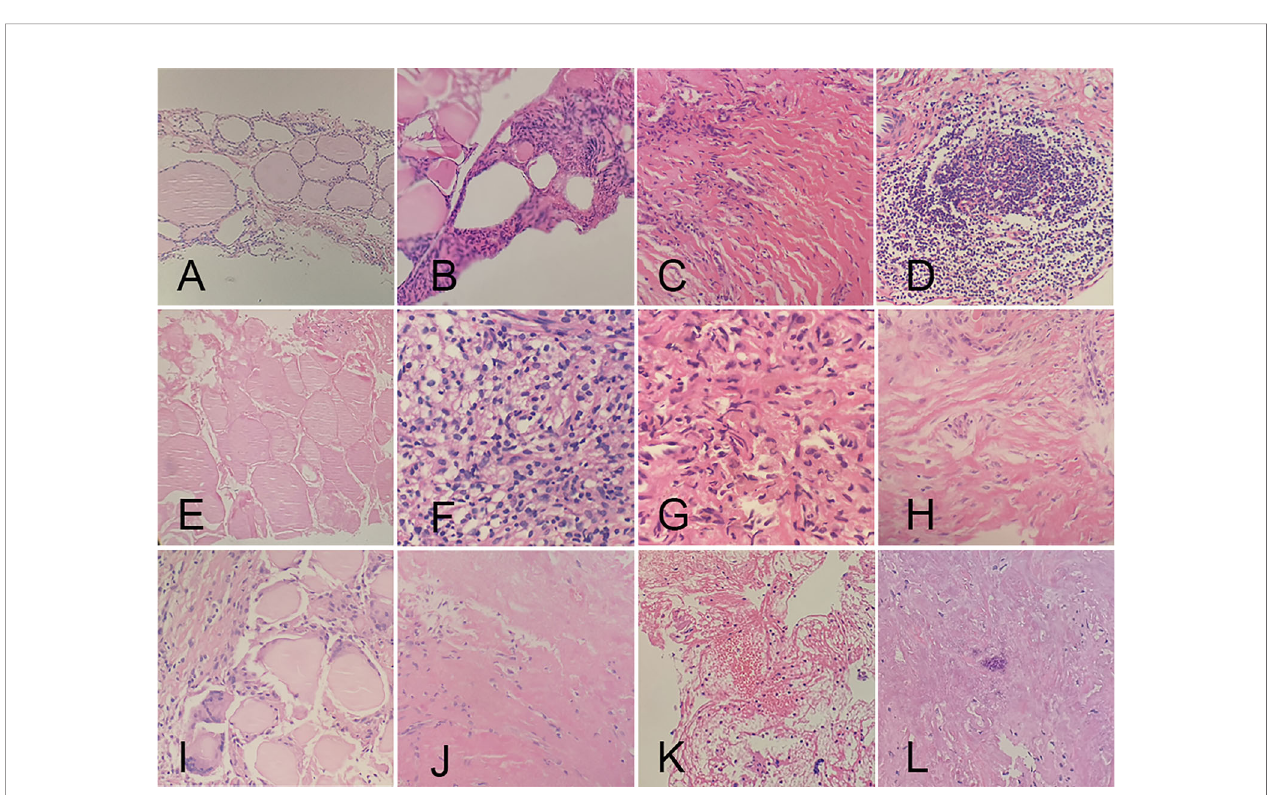
FIGURE 3 | Histopathologic characteristics of ablated areas after microwave ablation. (A) follicular cells; (B) atypical follicular cells; (C) fi broblastic proliferation; (D) chronic in fl ammation; (E) infarction; (F) histiocytic deposition; (G) blackish particle; (H) foreign body reaction; (I) cholesterol granuloma; (J) acellular hyalinization; (K) hemorrhage; (L) calci fi